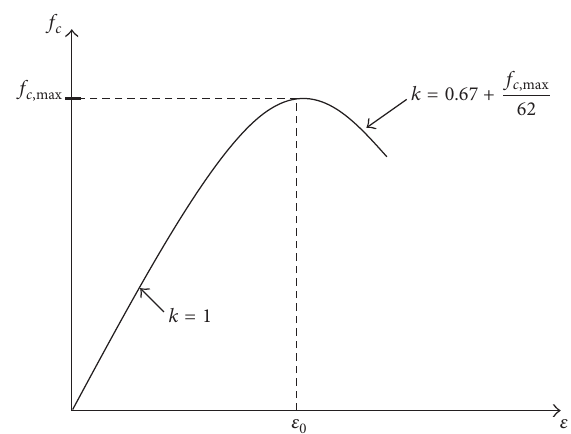
Figure 1: Stress-strain relationship in compression by Collins and Porasz